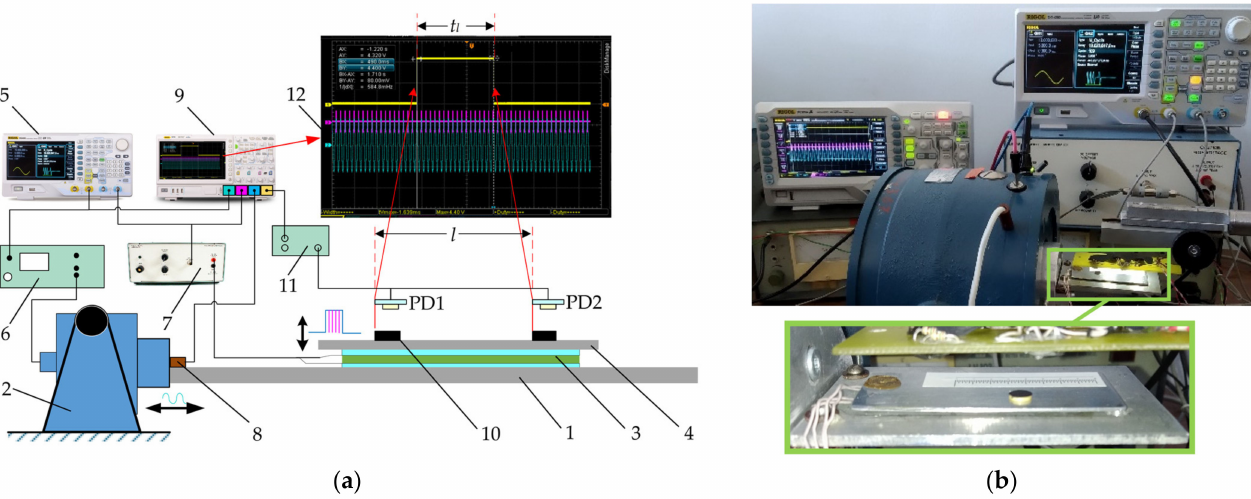
Figure 3. Experimental setup for manipulation of miniature bodies employing dry friction control: ( a ) principle diagram: (1), platform; (2), electrodynamic shaker; (3), piezoelectric actuator; (4), manipulation surface; (5), arbitrary waveform generator; (6), power amplifier; (7), piezo linear amplifier; (8), vibration sensor; (9), digital oscilloscope; (10), body to be manipulated; (11), photodiode signal generator; (12), view the oscilloscope screen; ( b ) general view and a zoomed view of the platform with manipulation